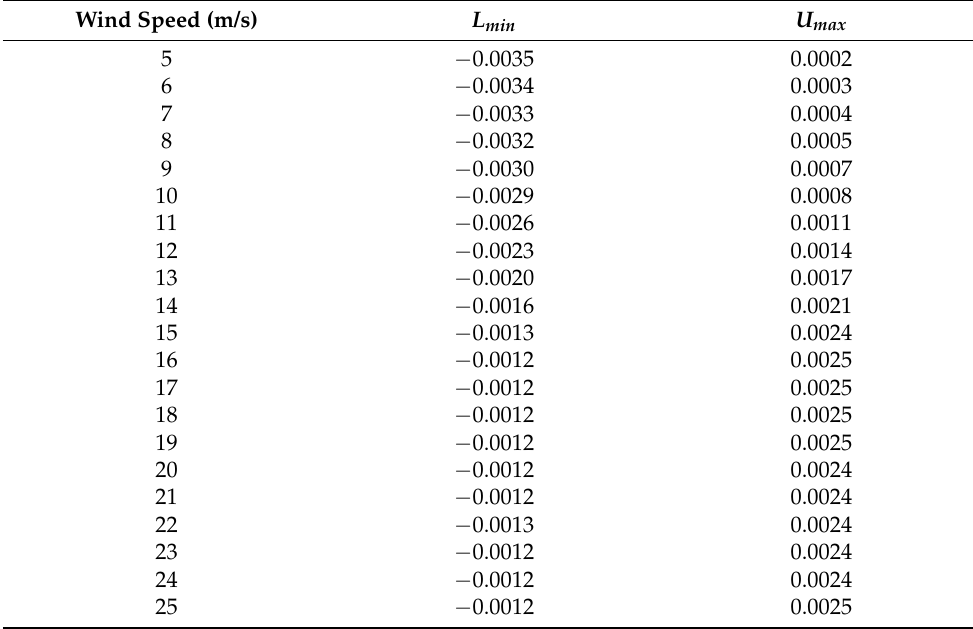
Figure 7. Rotor speed target and its corresponding output power via different wind speeds. Table 4. Upper and lower bounds of the rotor speed changing rate.